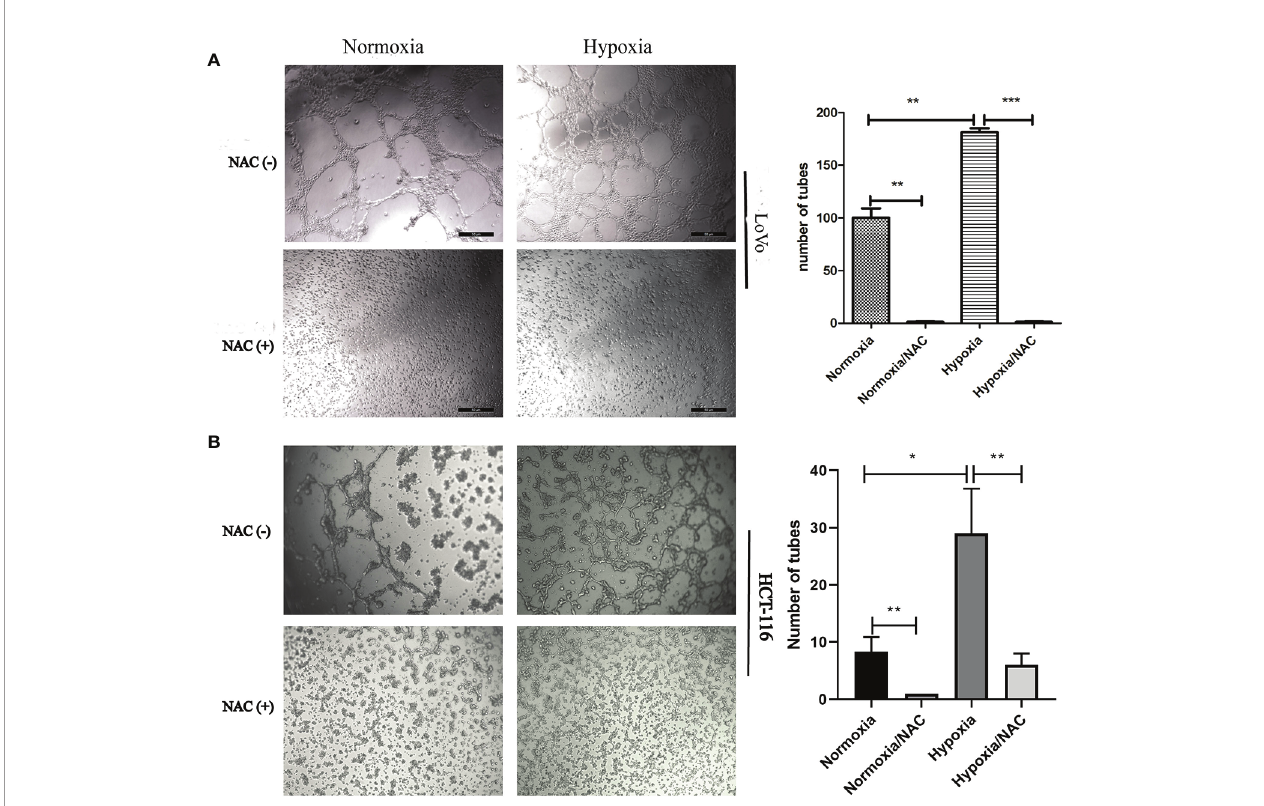
FIGURE 5 | Hypoxia accelerates vasculogenic mimicry and requires ROS generation. Vasculogenic mimicry of LoVo (A) and HCT-116 (B) cells was assayed after NAC treatment for 36 h at normoxia and hypoxia and photographed under 50× (LoVo) and 50× (HCT-116) magni fi cation; data are represented as mean ± SD from at least three experiments. (* P < 0.05, ** P < 0.01, *** P <